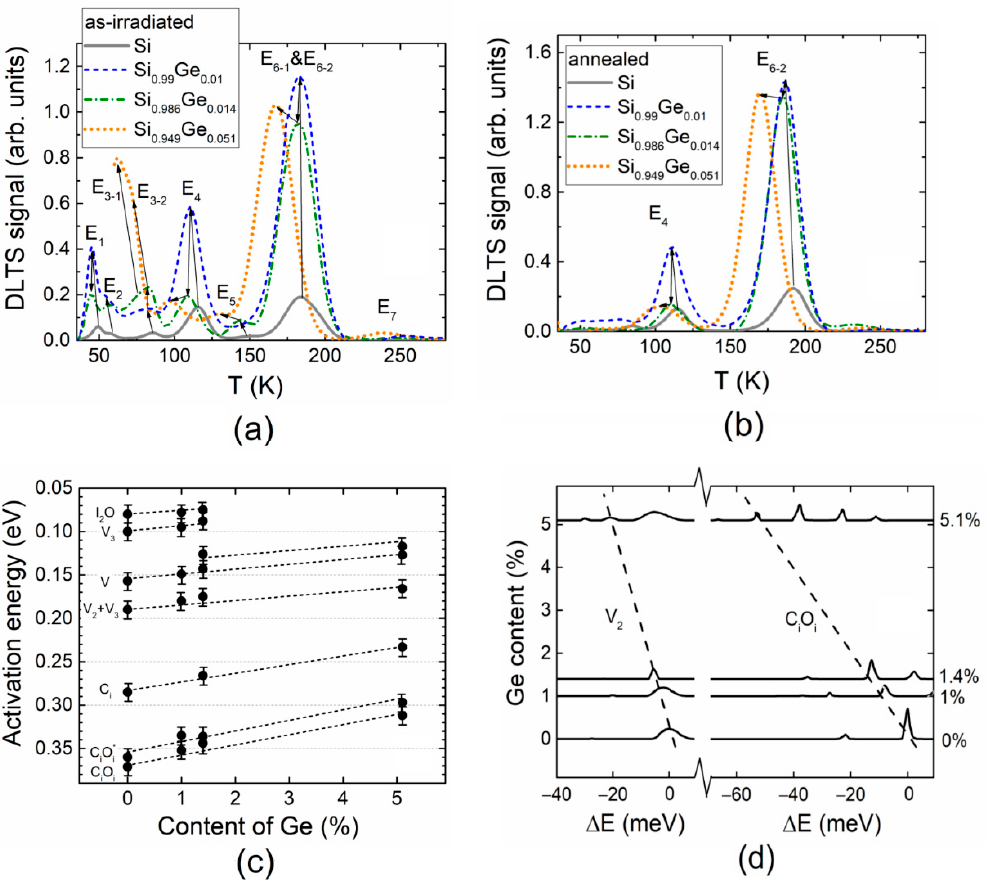
Figure 4. Comparison of the DLT spectra obtained in the as-irradiated ( a ) and annealed ( b ) Si and SiGe alloy samples. ( c ) The tendency of changes in the activation energy values of the radiation-induced traps in Si 1 − x Ge x alloy as a function of Ge content. ( d ) Ge content dependent variations in the Laplace DLT spectra obtained for V 2 and C i O i radiation-induced defects.